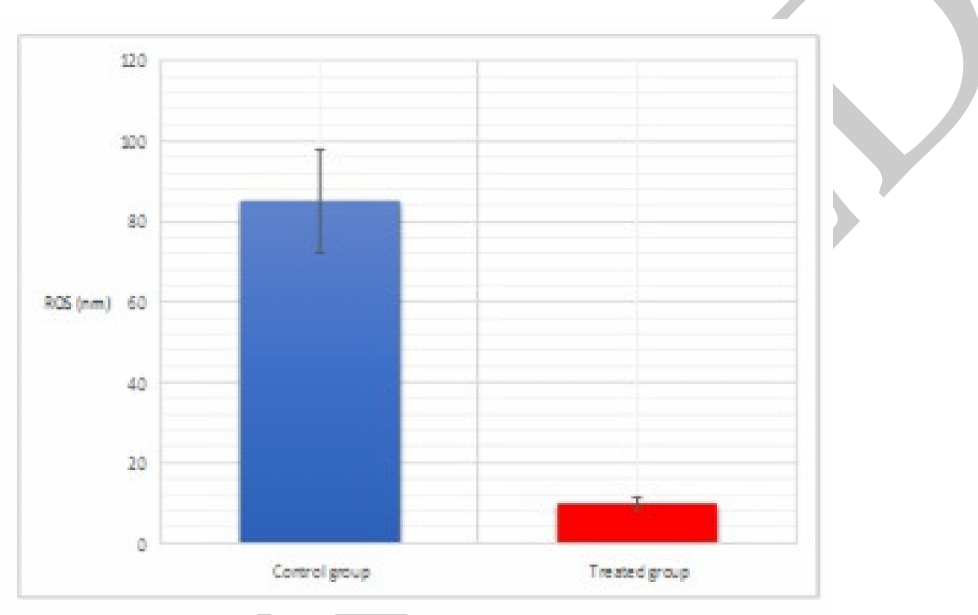
Figure 5. ROS levels in the serum were detected in diabetic untreated and treated group with C. molle .